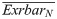
Evaluation plots for PP 2.(for a higher resolved image we refer to supplement S1 Fig). Upper left panel: Loadings of the PCA over RWS coloured according to the PCGA gradient. Axis labels refer to PC relative importance. Three upper right panels: Detected gradients plotted against known gradients for PCGA, GR, and TR, respectively. Headers of these panels reflect the correlation coefficient between detected and true gradient. Mid left: grbarN plotted against ExrbarN¯ along the population gradient for both population margins (red and blue lines). Both grbarN strongly suggest a population gradient as being well above ExrbarN¯. Mid right: HCA dendrogram suggested defining two responder chronologies which mostly correctly split RWS along the known gradient. Lower left: PCGA responder chronologies (coloured curves) show a minimum correlation of 0.74 among each other. Two lower right panels: RWS signal correlations (small dots coloured according to PCGA gradient) show a clear relationship with PCGA gradient. PCGA (coloured ‘◊’) and HCA (black ‘X’) responder chronologies show equal signal correlations of which the marginal responder chronologies express higher correlations than the population master (grey ‘+’).